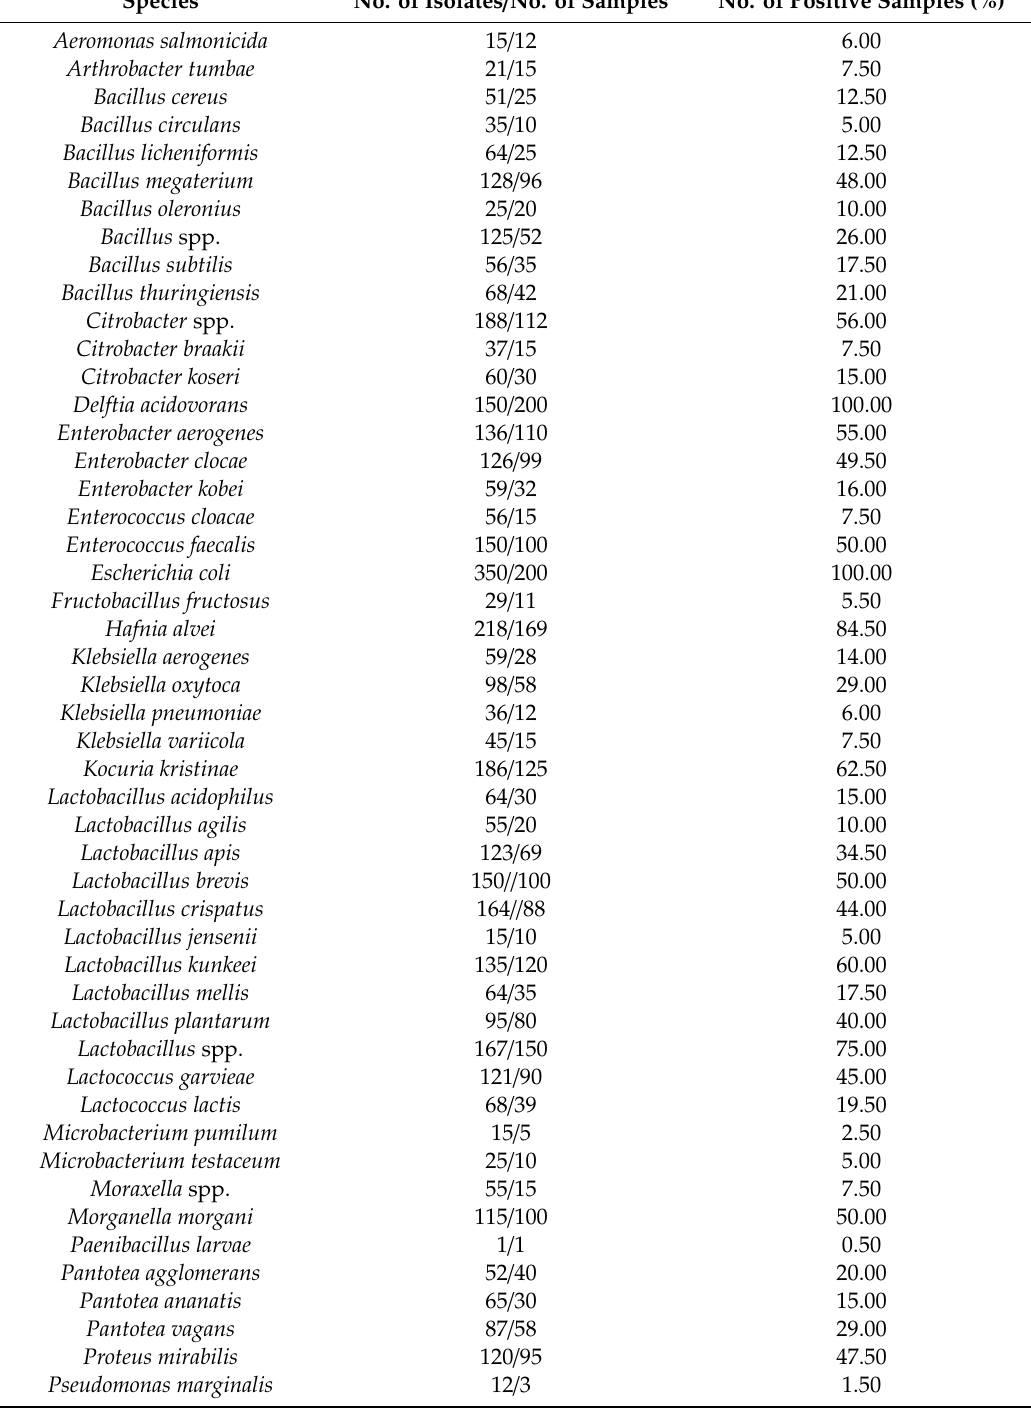
Table 3. Frequency of isolated bacteriota (%) detected in the samples of bee digestive tract. Species No. of Isolates / No. of Samples No. of Positive Samples